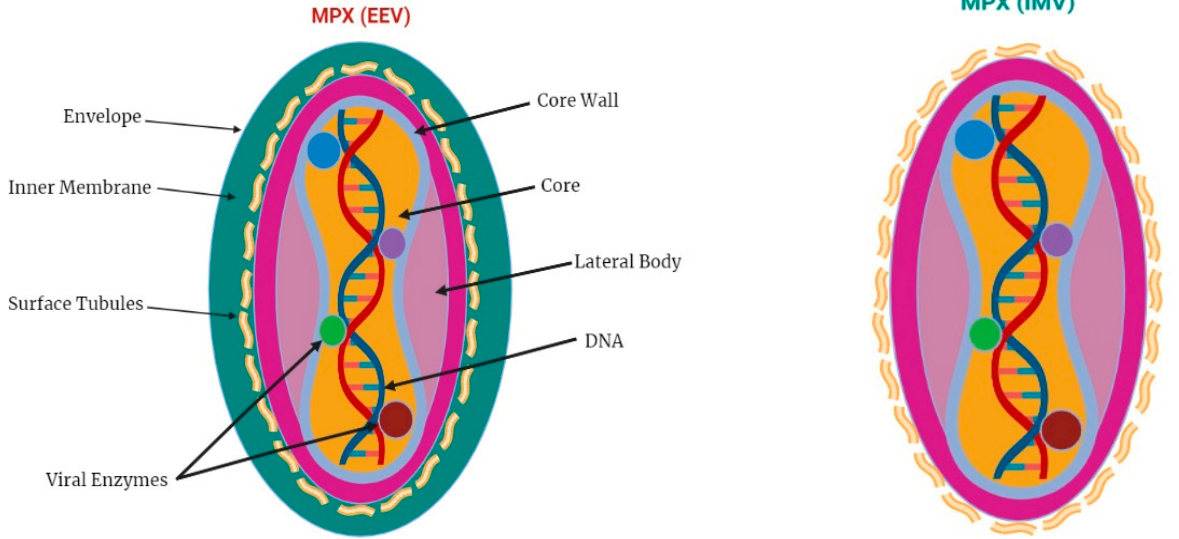
Figure 1. Viral envelope structure, including extracellular enveloped virus (EEV) and mature intra- cellular virions (IMVs) [25].